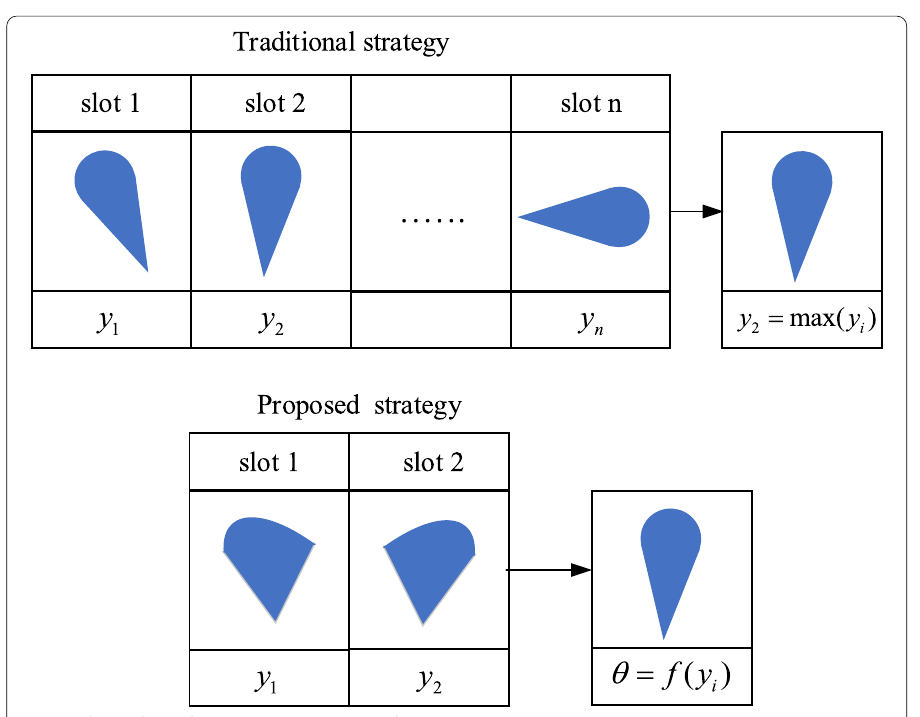
Fig. 2 The traditional strategy versus proposed